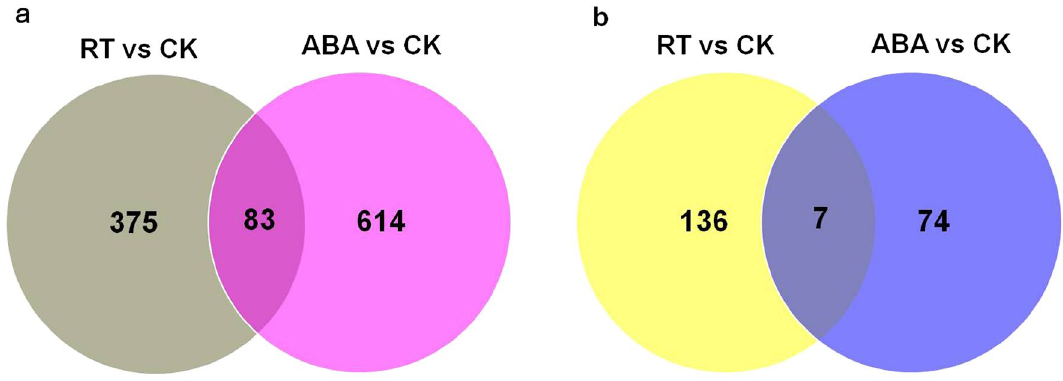
Figure 3. Venn diagrams of differentially expressed genes ( a ) and lncRNAs ( b